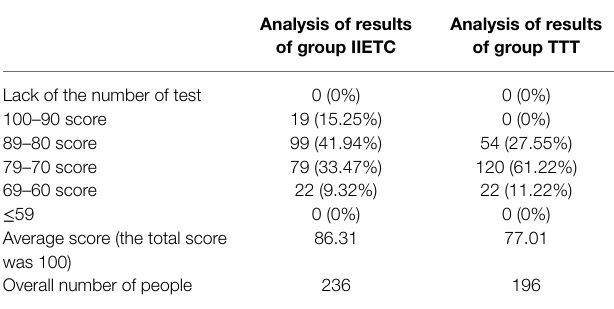
TABLE 3 | The impact of IIETC on students response (in-class group). Variables